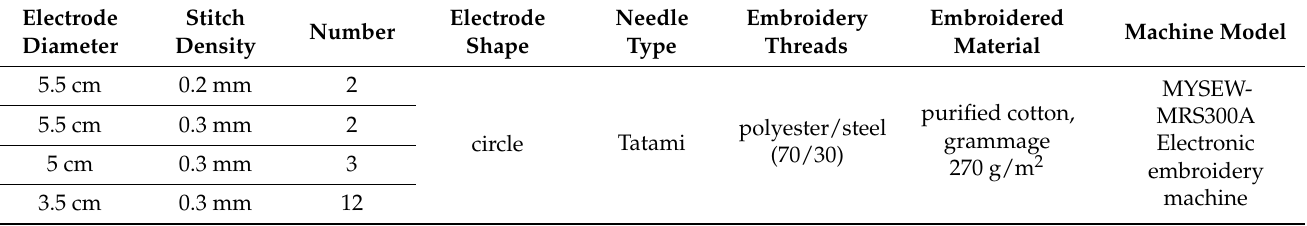
Table 1. Preparation of electrode for embroidery